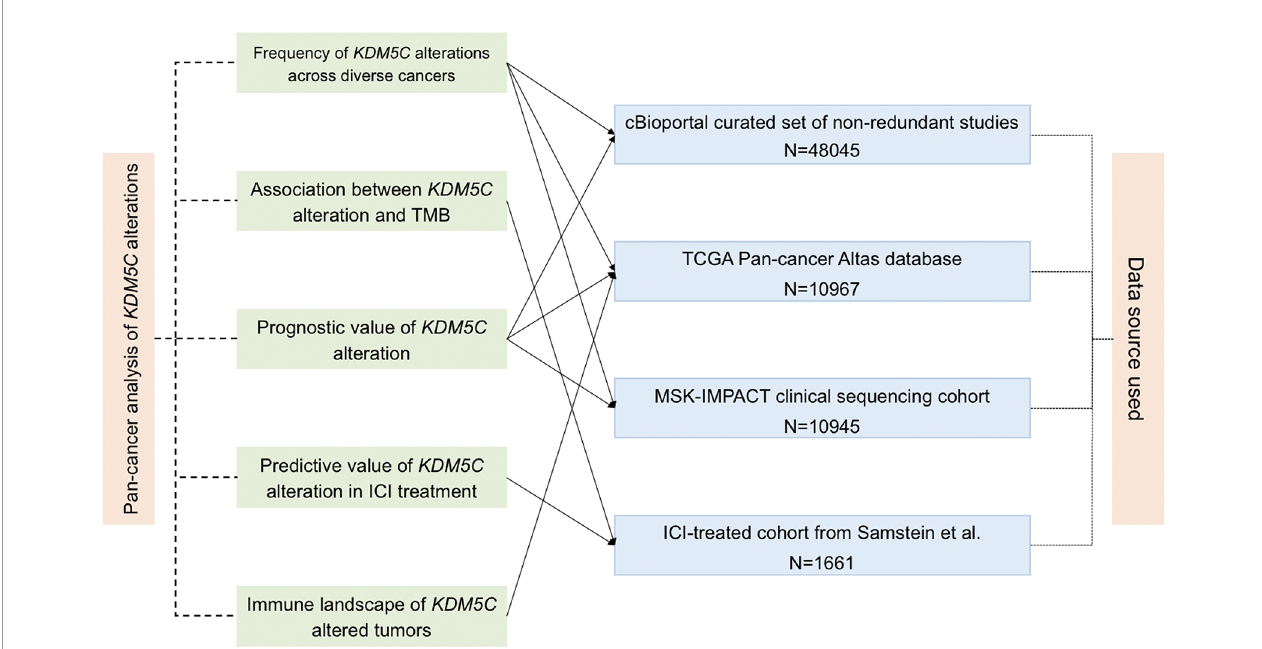
FIGURE 1 | Flowchart of the sequenced data and clinical cohort. The connected solid line between analysis aim (middle left) and data source (middle right) means the used cohort by this